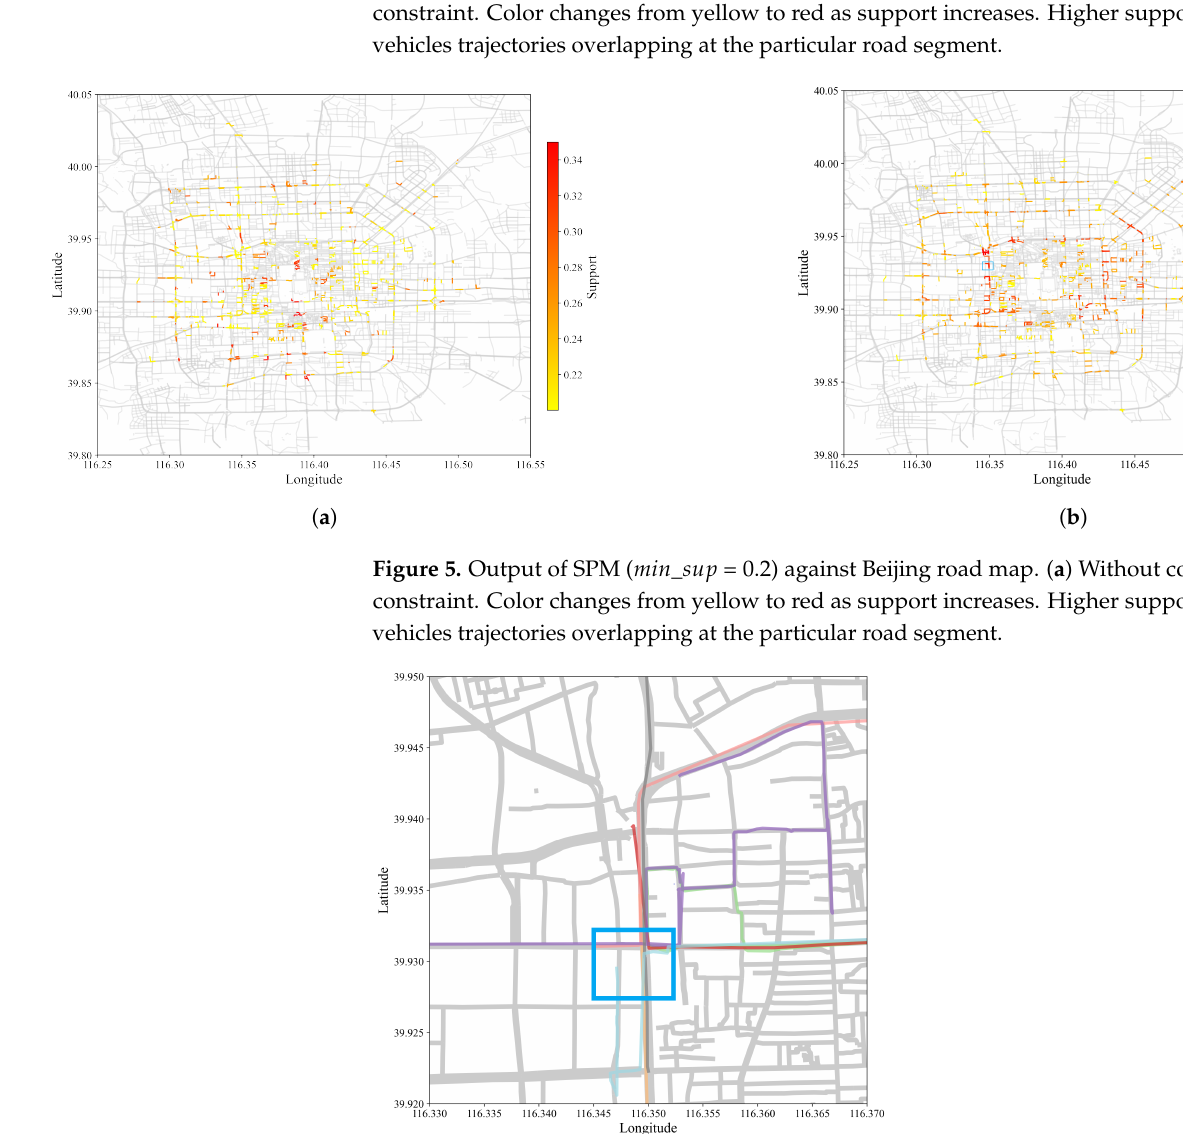
Figure 6. An example of sequential pattern mined in the blue boxed region (Figure 5b) with actual trajectories(colored lines) against the roads (grey